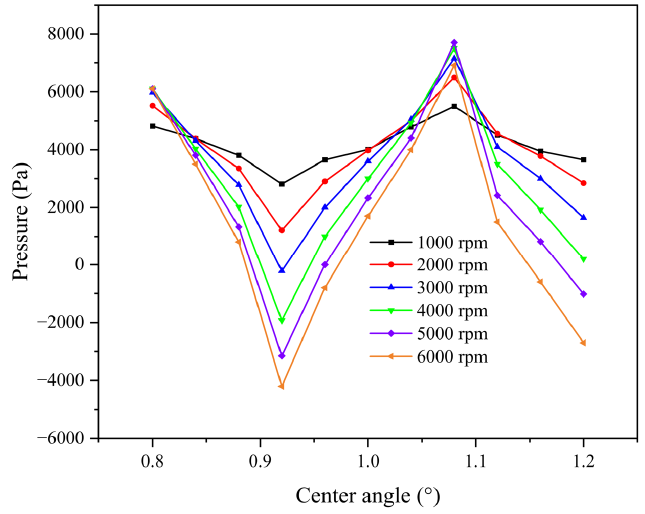
Figure 17. Pressure distribution in a single textured dimple without the cavitation effect at different rotational speeds.